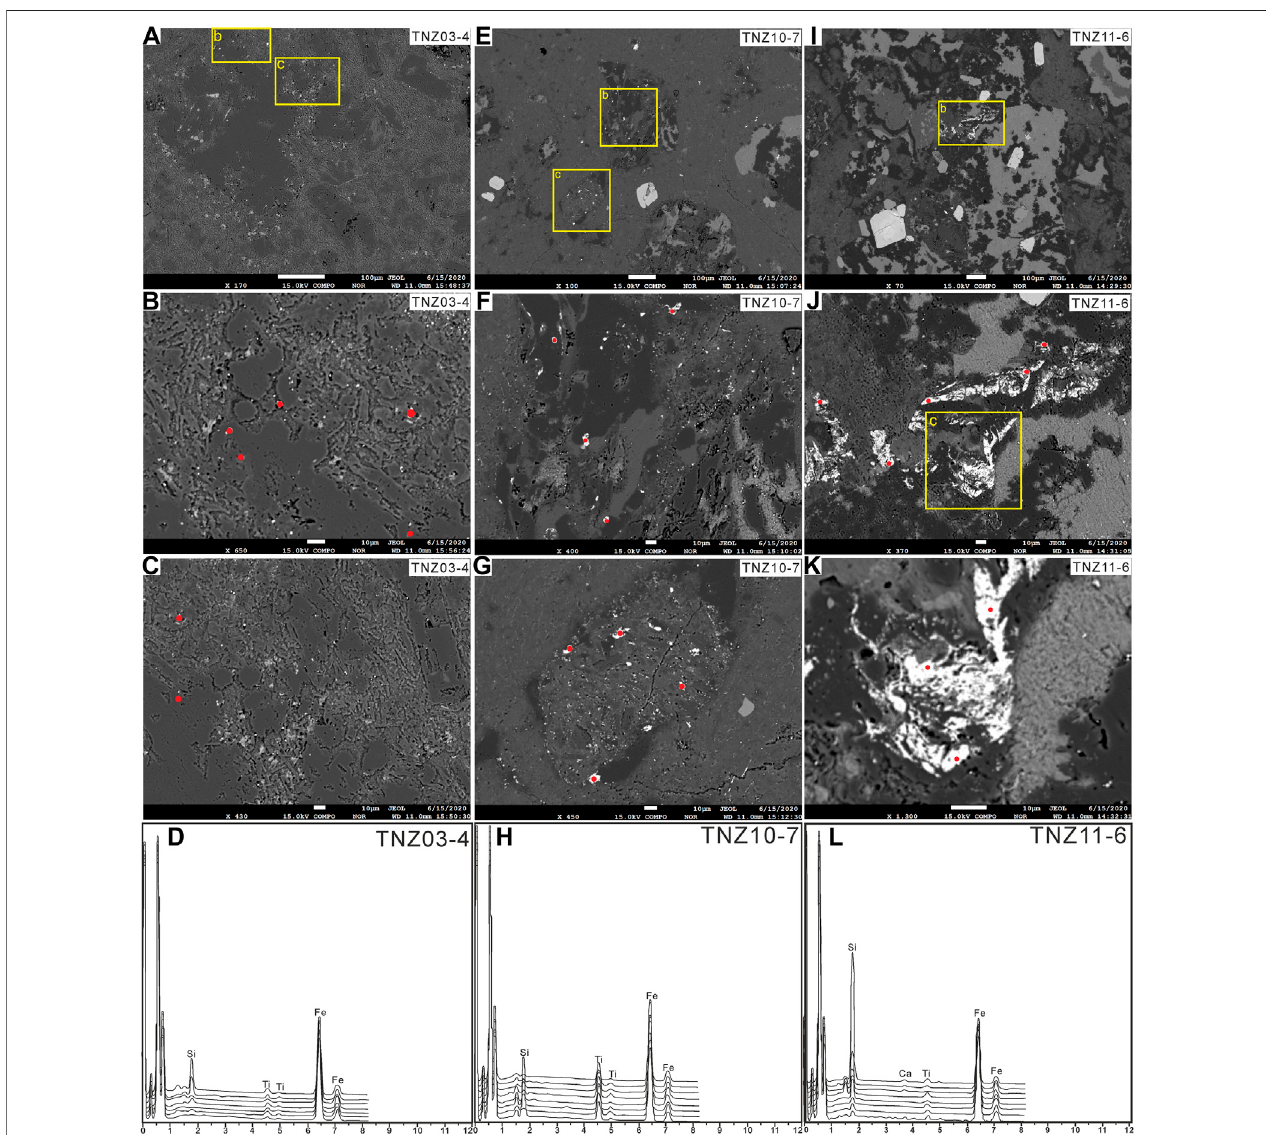
FIGURE 6 | BSE images and EDS analysis for representative samples from the Zonggei Formation volcanic rocks. The red-colored dots in sub fi gures of (B,C) , (F, G) , and (J,K) indicate spots where the EDS analyses were performed. Measurements and analytical results are shown in sub fi gures (D,H,L) . Areas enclosed by yellow rectangles are enlarged in subsequent sub fi